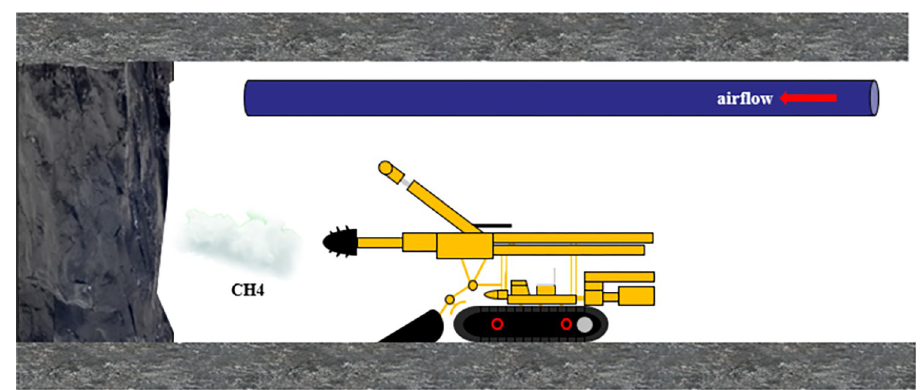
Fig 9. Engineering background.